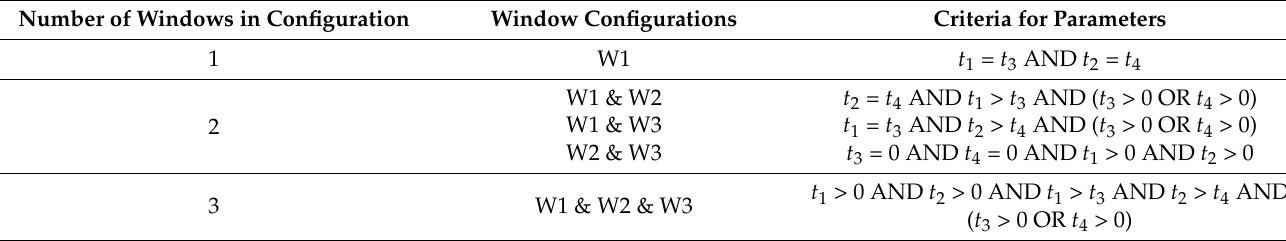
Table 2. Criteria for parameters to form specific data segmentation window configurations for testing. Number of Windows in Configuration Window Configurations Criteria for